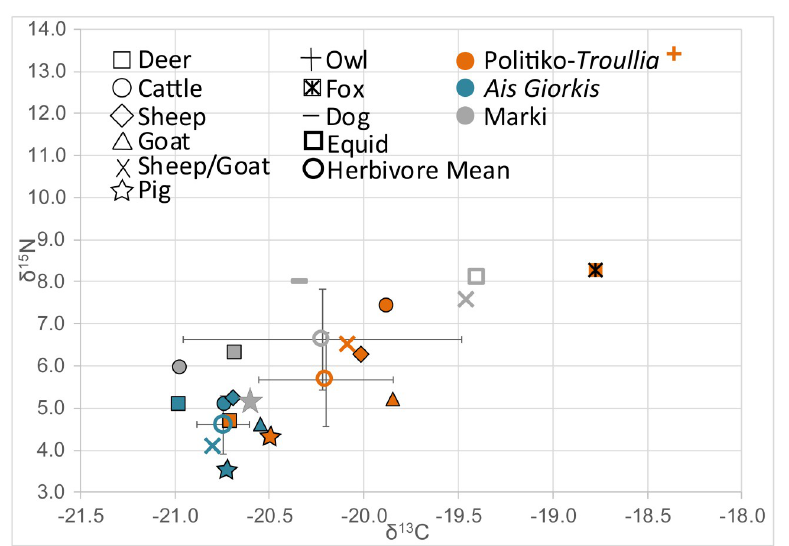
Fig 6. Means for δ 13 C and δ 15 N from bone collagen according to taxon, plus standard deviations for herbivores. Politiko- Troullia (PT), Ais Giorkis (AG) (data from [65]) and Marki Alonia (MA) (data from [66]).